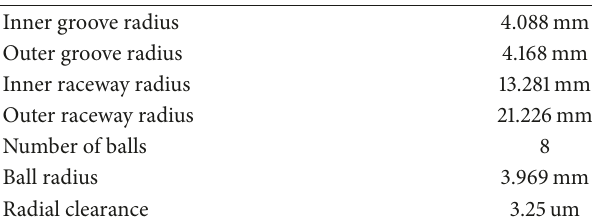
Table 1: Parameters of the type 6204